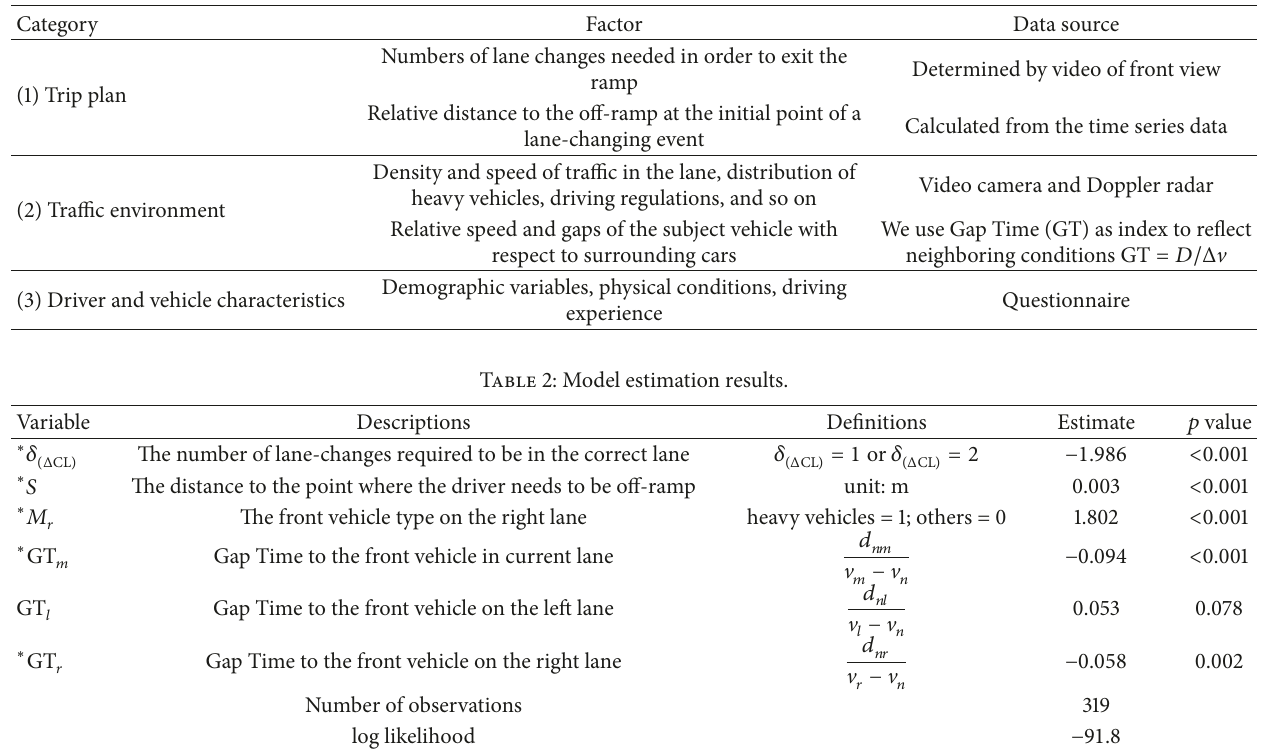
Table 1: Potential factors contributing to the lane change.